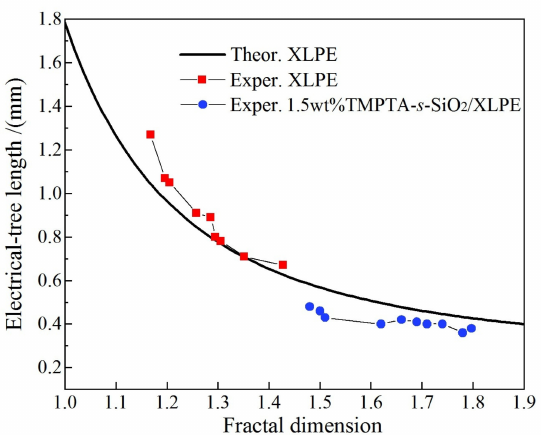
Figure 8. Growth length versus fractal dimension of electrical-trees in pure XLPE and 1.5 wt%TMPTA- s -SiO 2 /XLPE nanocomposite.